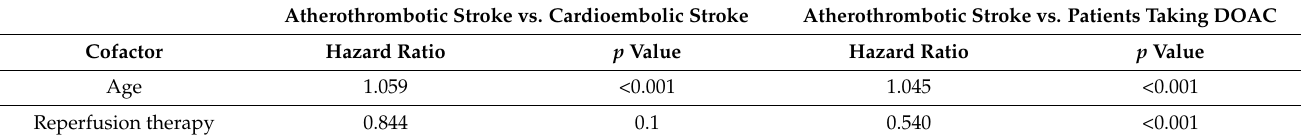
Table 3. Cox regression measure among the patient groups.